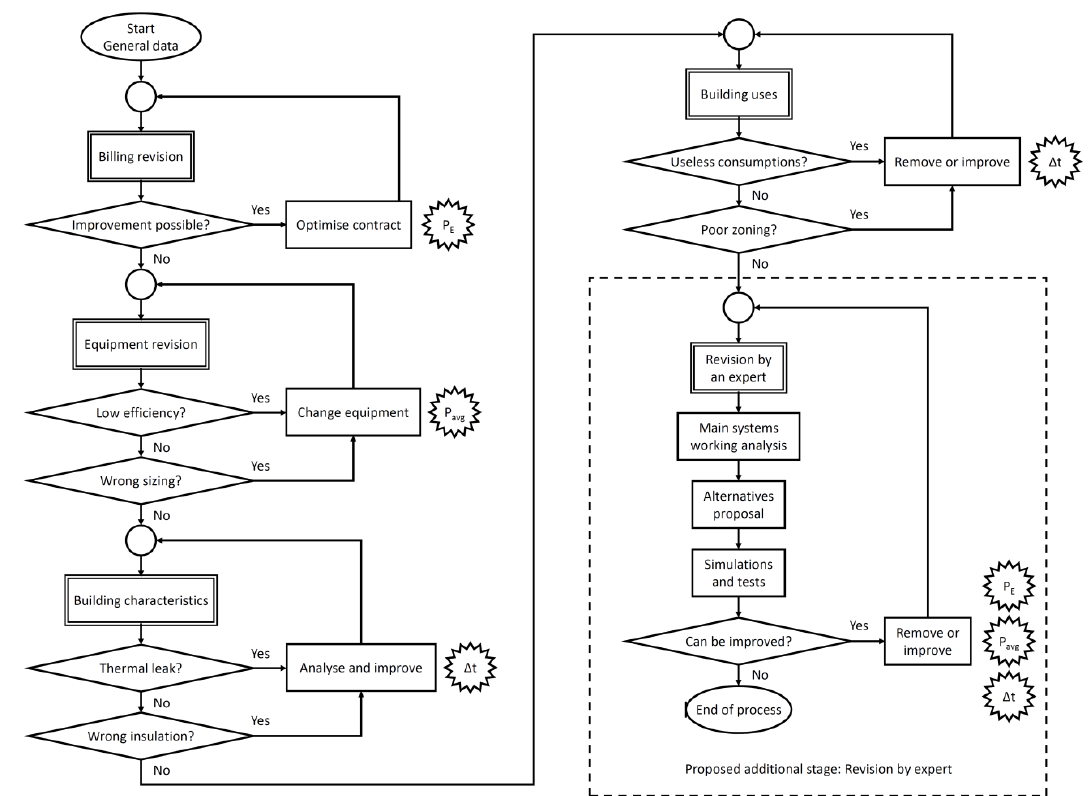
Figure 1. Diagram of classical methodology in an energy saving study and additional proposed phase.